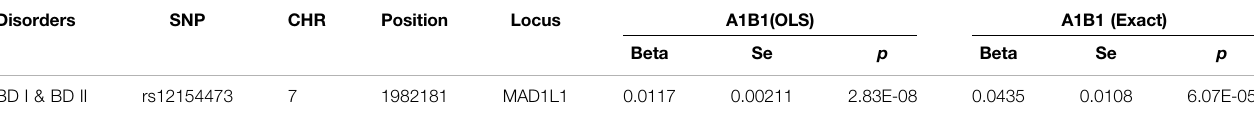
TABLE 2 | Distinguished loci between BD I and BD II by CC-GWAS results at OLS < 5 × 10 − 8 and EXACT < 1 × 10 − 4 .